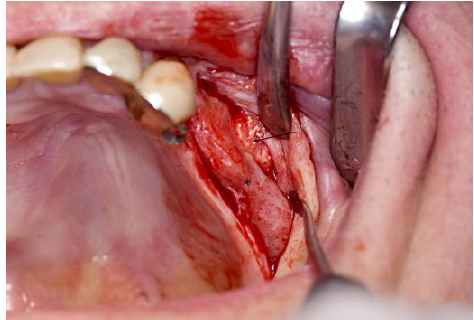
Figure 4. Clinical outcome. At the time of re-entry for implant insertion, the scaffolds showed a sufficient osseointegration without any signs of inflammation. The fixation screw was covered by bone (*). The structure of the scaffold is visible at the lateral aspect of the sinus wall (black arrow).